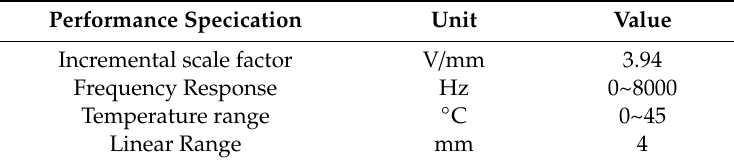
Table 3. The main parameters of the eddy current sensor.